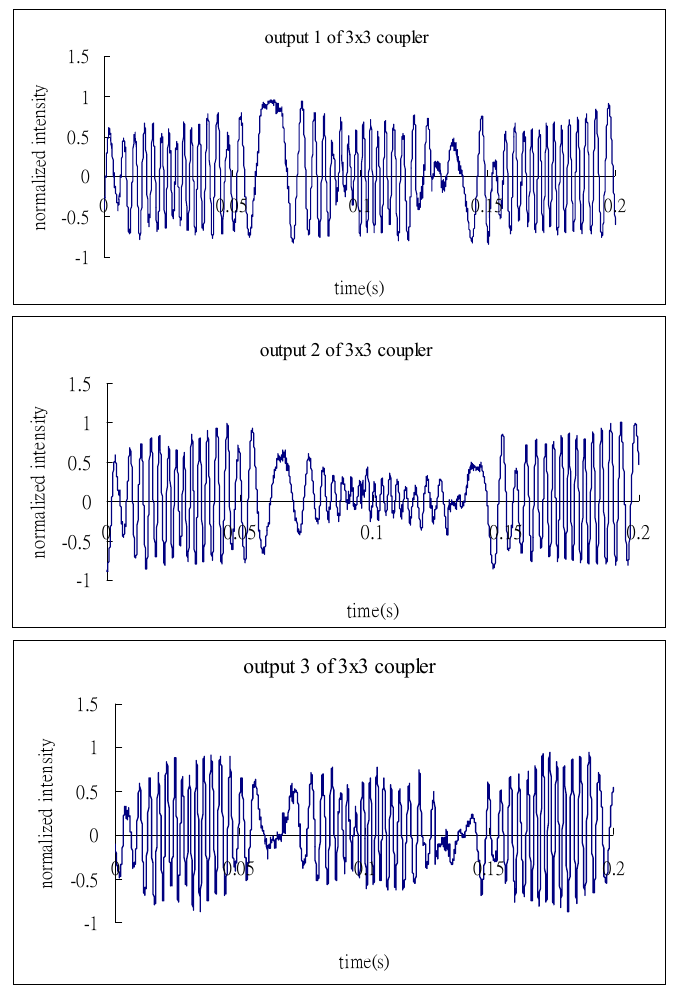
Figure 7. Three outputs of the 3 × 3 coupler with excitation frequency of 7